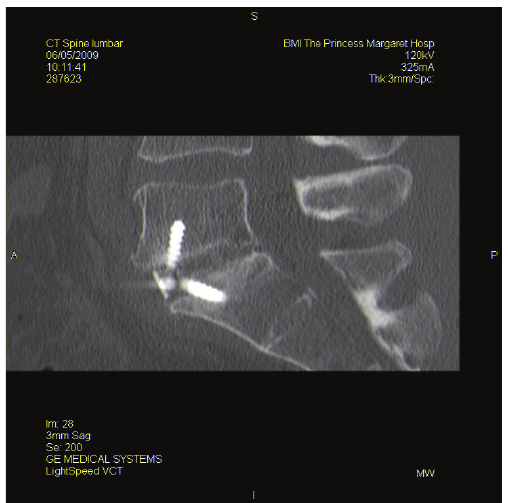
Figure 3: Axial view of bilateral L5 pedicle fracture.